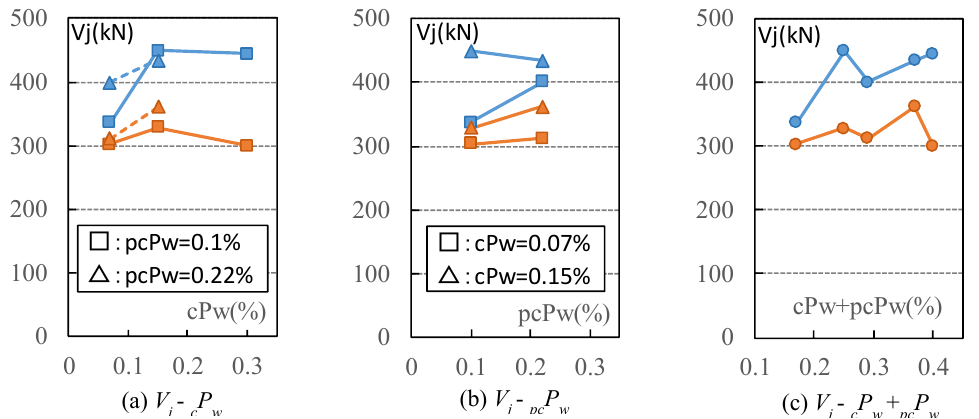
Figure 7. Relationship between maximum input shear force and two kinds of hoop in pile cap.